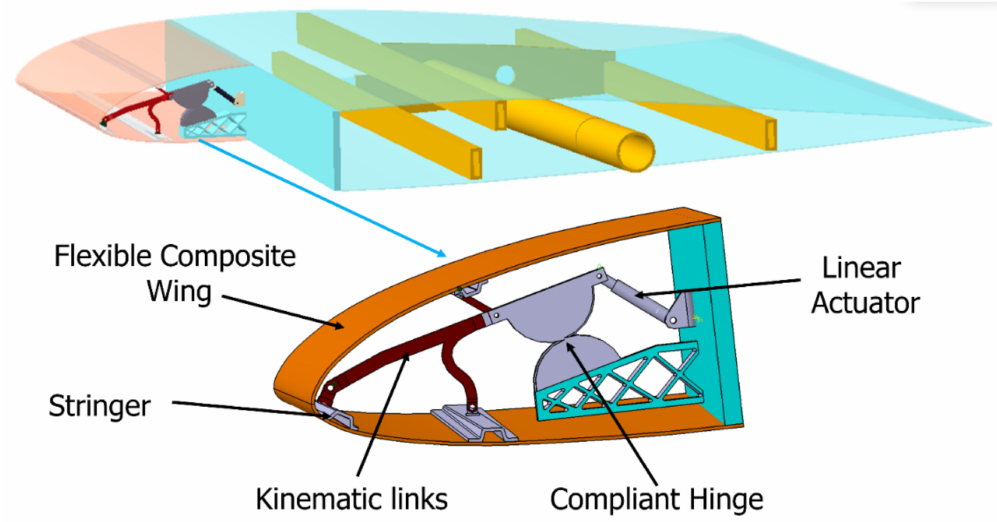
Figure 18. L.E. geometry at the reference section.